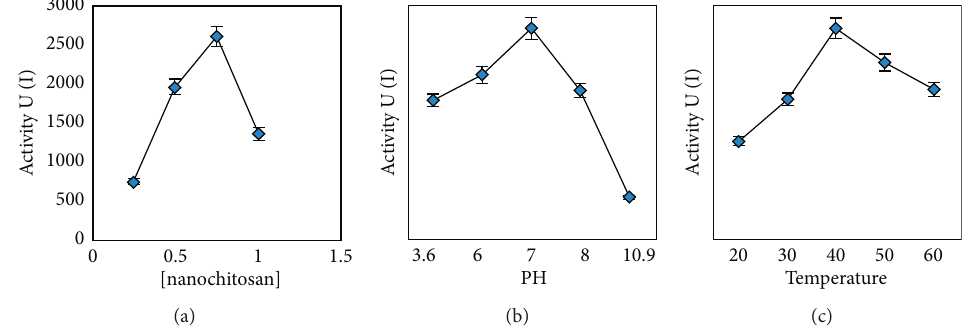
Figure 1: Kinetics of immobilized enzyme. Effect of amount of chitosan NPs on immobilization urease activity (a), the effect of pH on the enzyme activity (b), and the effect of temperature on the activity of immobilized enzyme